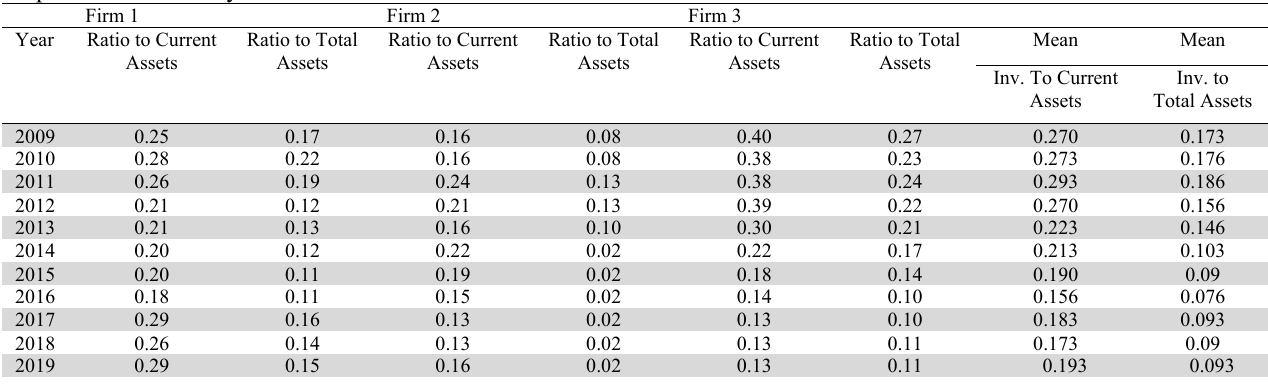
Proportion of Inventory to Each of Current and Total Assets